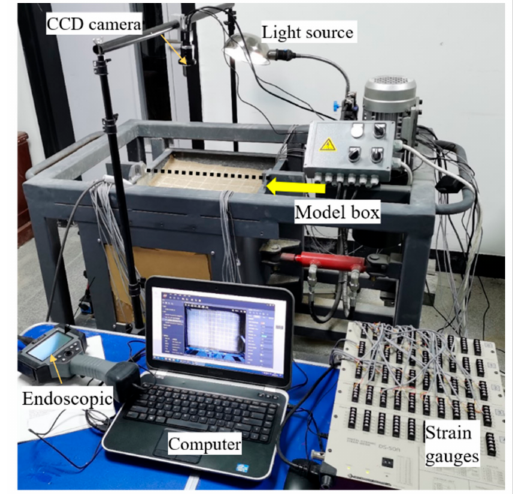
Figure 3. Measuring instruments of model